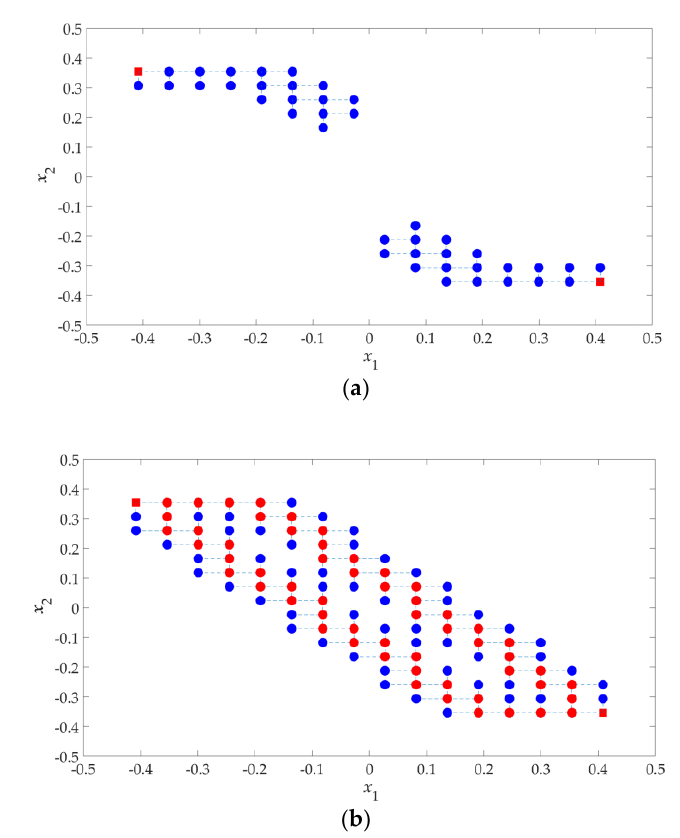
Figure 2. Illustration of the process of finding a Pareto set boundary by using an updated SDP method: ( a ) Starting points (red square) and perturbation points (blue dot, where the best perturbations become the centers of the next patches) of the first 10 iterations; ( b ) Pareto set boundary (red points) found.